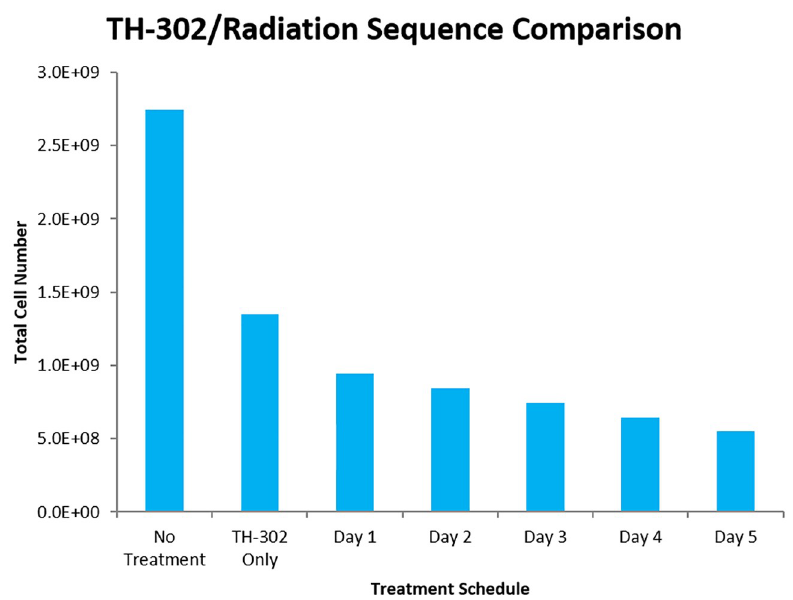
Fig 5. Efficacy of TH-302/radiotherapy combinations based on administration sequence. The tumour is allowed to grow for 15 days with TH-302 treatment starting on the 15th day. TH-302 is then given every day for 5 straight days with radiation given 6 hours after TH-302 on one of the days. Resulting cell number is calculated at the end of the 5th day, after all treatment has ceased. Notice that the later radiotherapy is administered, the more tumour cells are killed.